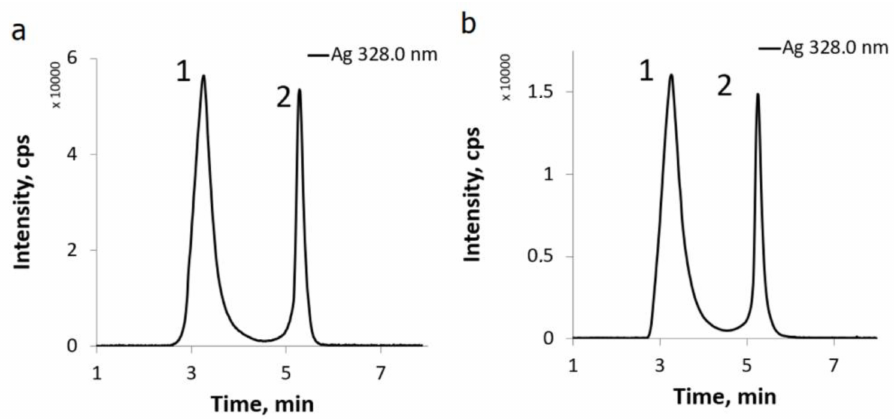
Figure 5. The HPLC-ICP-AES chromatogram of the Ag clusters in coordinates “retention time–line intensity”: ( a ) fresh solution of AgSO 3 CF 3 and AgS t Bu in DMSO, ( b ) after 8 h. Peaks No.1 and No.2 correspond to silver clusters containing 19 and 20 atoms, respectively.